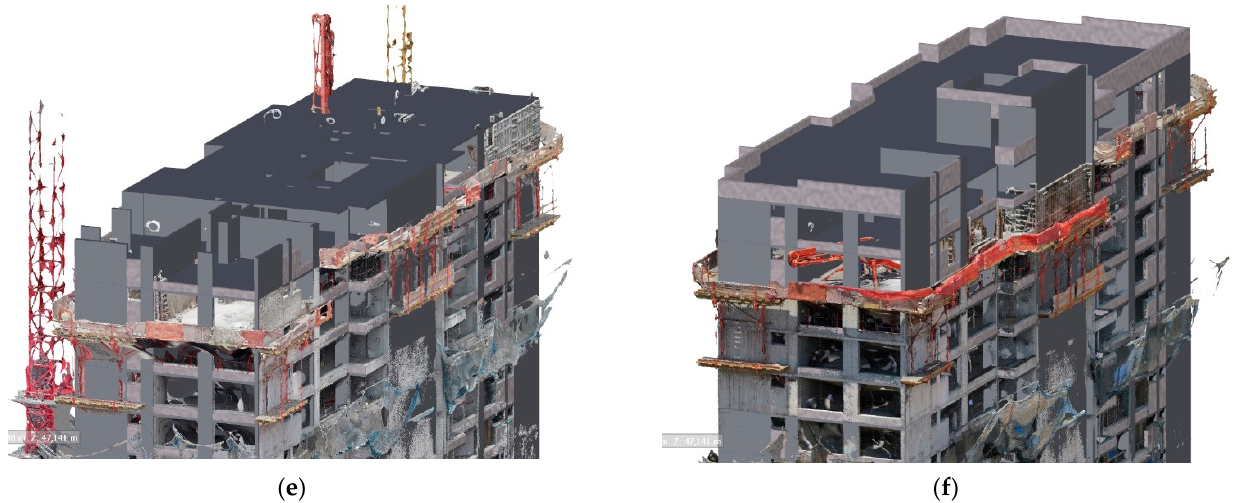
Figure 8. Superposition of point cloud and as-planned model on each inspection day—overlap at ( a ) day 0, ( b ) day 12, ( c ) day, ( d ) day 24, ( e ) day 30, and ( f ) day 41.